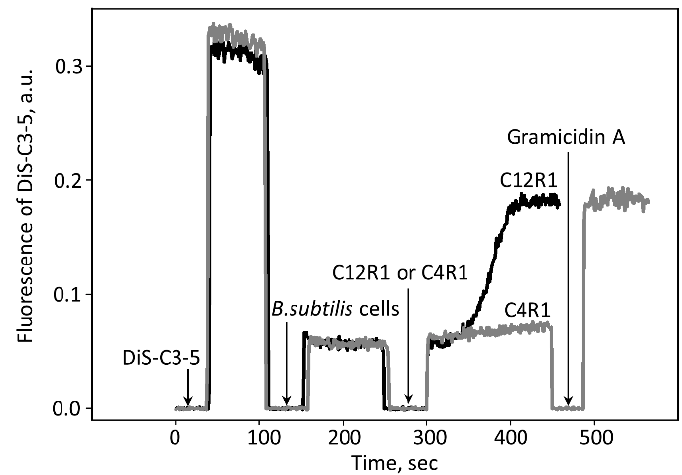
Figure 3. Changes in the electric potential across the membrane of B. subtilis . Changes in the membrane potential were monitored by measuring fluorescence of DiS-C3-(5) (10 µ M) in PBS buffer. The short time intervals with the fluorescence falling to zero are caused by the opening of the chamber for making additions. C4R1 (0.6 µ M) and C12R1 (0.6 µ M) were added as shown. Gramicidin A (0.5 ng/mL) was added at the end of the experiment for perforation of the cell membrane to collapse the membrane potential.